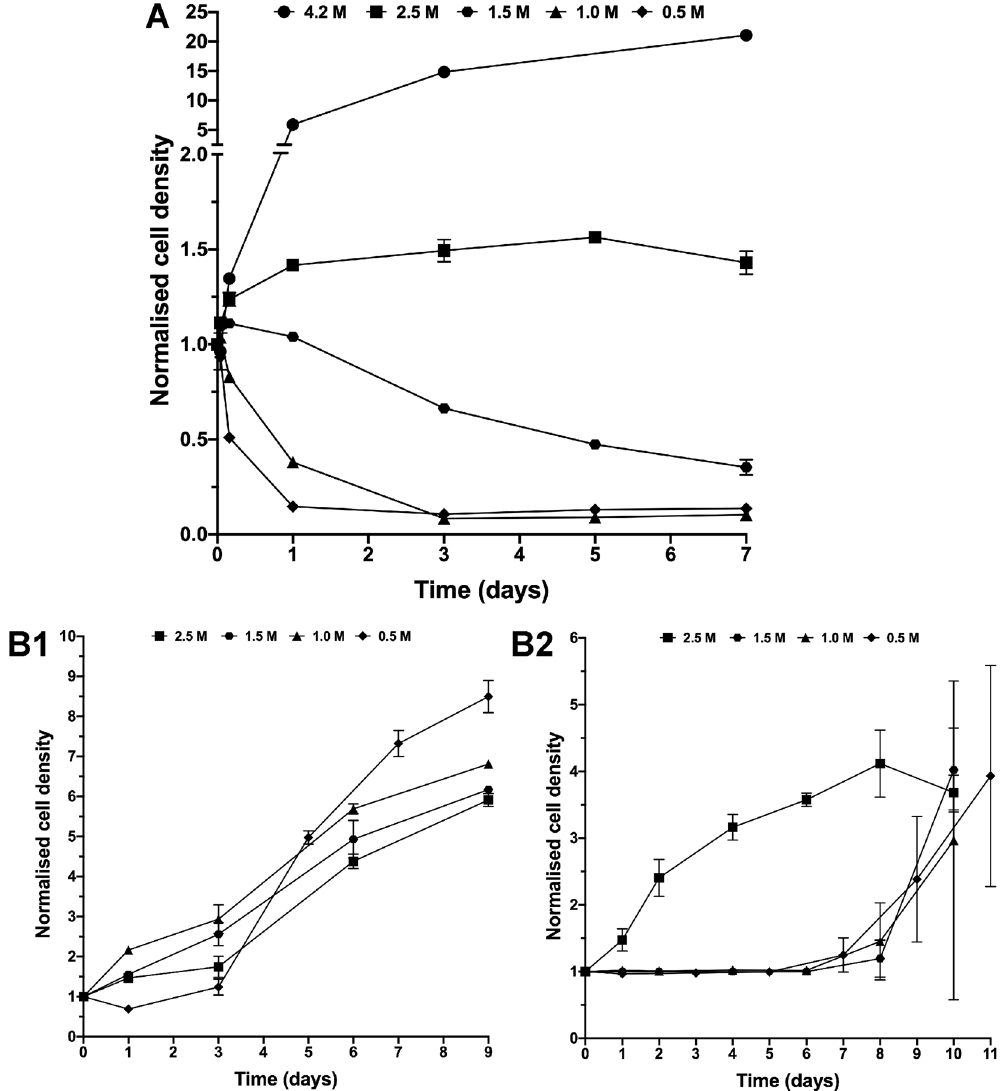
Figure 1. ( A ) Normalized cell density of Halobacterium salinarum as a function of time for different salt (NaCl) concentrations. Cells grown in 4.2 M NaCl were harvested then cultivated at 37 °C under aerobic conditions in rich medium with 2.5 M, 1.5 M, 1.0 M and 0.5 M NaCl. ( B ) Growth kinetics of Hbt. salinarum during recovery. Cells were shocked in 2.5 M ( ■ ), 1.5 M ( ▲ ), 1.0 M ( ● ) and 0.5 M (x) NaCl for 1 hour ( B1 ) or 7 days ( B2 ) and then were incubated in 4.2 M NaCl for recovery. Growth was monitored as optical density of the culture. Each experiment was carried out in triplicate. Errors bars represent standard